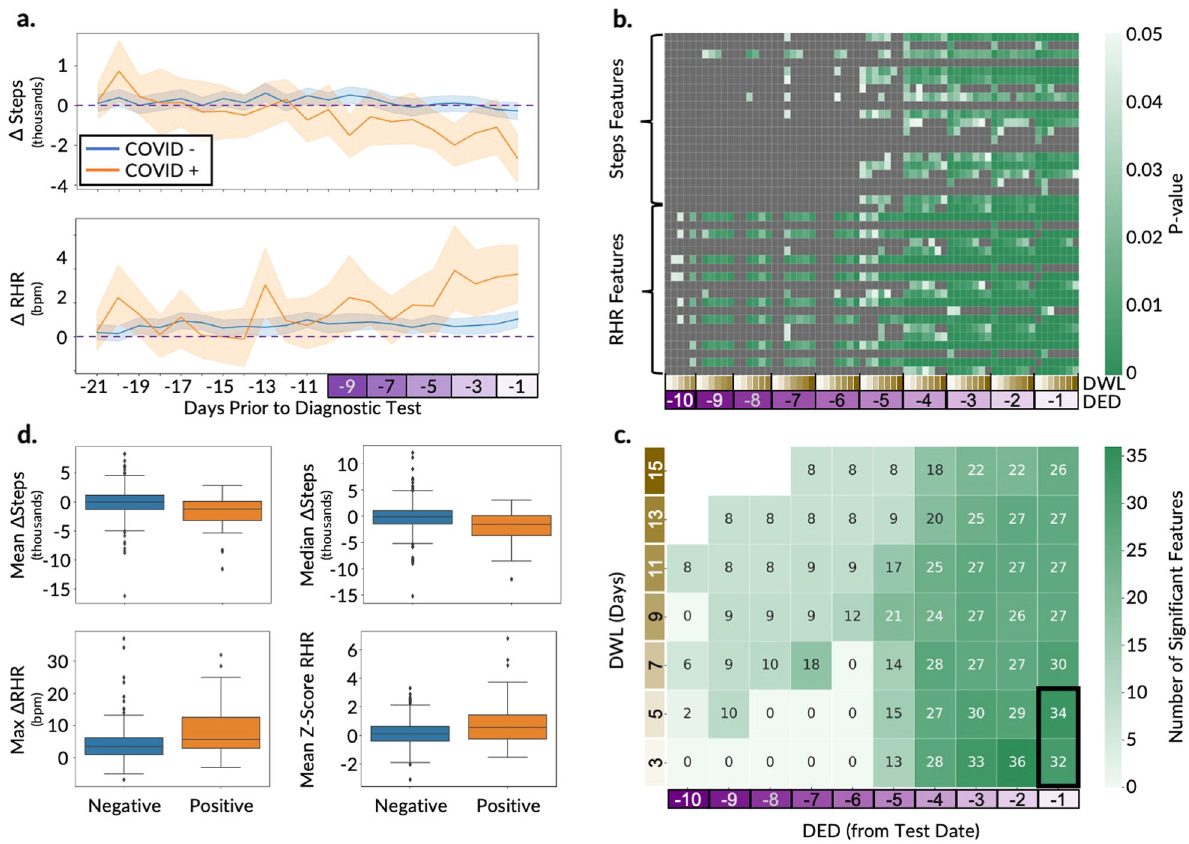
Fig. 2 Overview of digital biomarker exploration and feature engineering for the ITA model development on the AF cohort. a Time-series plot of the deviation in digital biomarkers ( Δ Steps and Δ RHR) in the detection window compared to baseline periods, between the participants diagnosed as COVID-19 positive and negative. The horizontal dashed line displays the baseline median and the con fi dence bounds show the 95% con fi dence intervals. b Heatmaps of steps and RHR features that are statistically signi fi cantly different ( p value <0.05; unpaired t -tests) in a grid search with a different detection end date (DED) and detection window length (DWL) combinations, with green boxes showing p values <0.05 and gray boxes showing p values ≥ 0.05. The p values are adjusted with the Benjamini – Hochberg method for multiple hypothesis correction. c Summary of the signi fi cant features ( p value <0.05; unpaired t -tests) from b , with each box showing the number of statistically signi fi cant features for the different combinations of DED and DWL. The intersection of the signi fi cant features across DWL of 3 and 5 days with a common DED of 1 day prior to the test date (as shown using the black rectangle) was used for the ITA model development. d Box plots comparing the distribution of the two most signi fi cant steps and RHR features between the participants diagnosed as COVID-19 positive and negative. The centerlines denote feature medians, bounds of boxes represent 25th and 75th percentiles, whiskers denote nonoutlier data range and the diamonds denote outlier